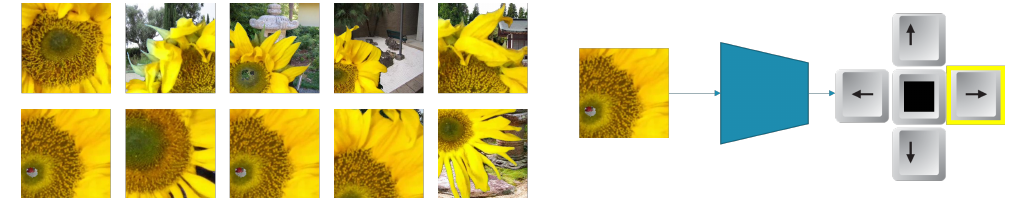
Figure 13. ( Left ): example images from the direct visual servoing image dataset. ( Right ): The proposed direct visual servoing